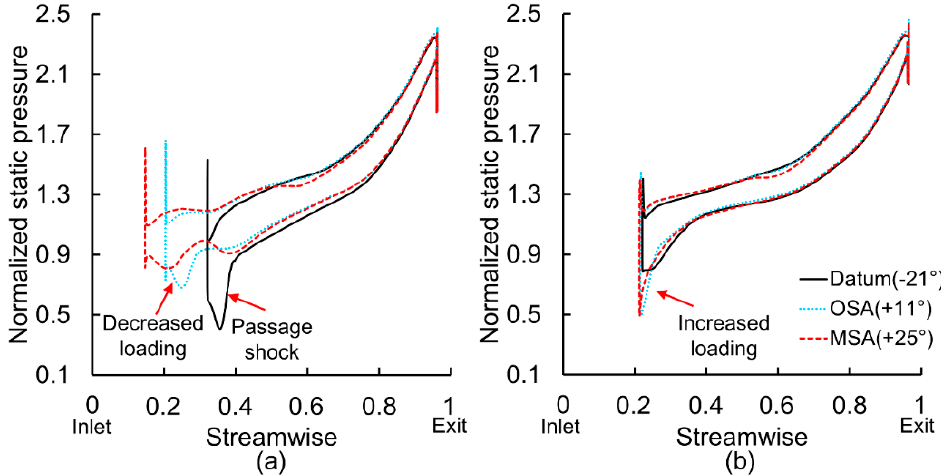
Figure 14. Static pressure distribution of main blade at ( a ) 95% span and ( b ) 5% span.